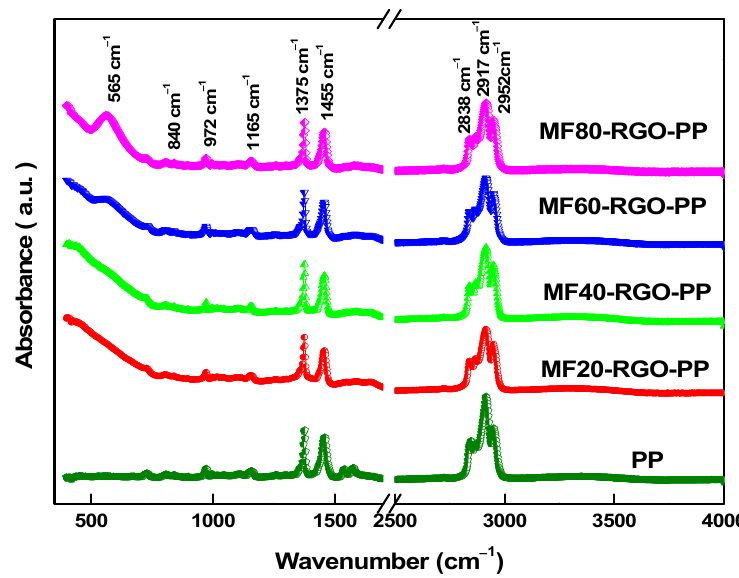
Figure 8. FTIR spectrum of (a) polypropylene (PP), (b) MF20-RGO-PP, (c) MF40-RGO-PP, (d) MF60- RGO-PP and (e) MF80-RGO-PP.